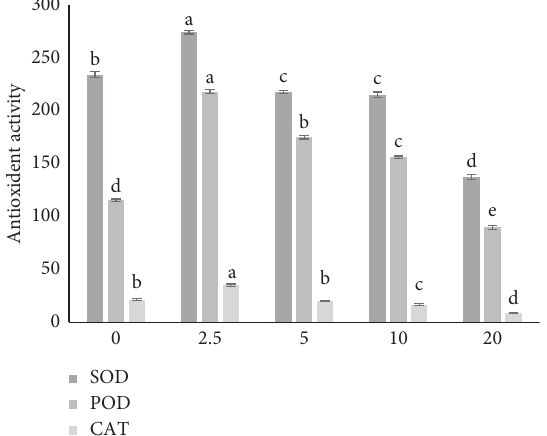
Figure 1: Superoxide dismutase (SOD), peroxidase (POD), and catalase (CAT) of maize grown under different treatments of Se. Error bars represent the SE for the mean of three